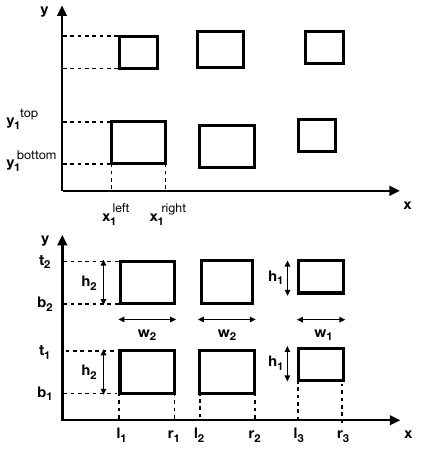
Figure 4. Names of float variables for rectangle coordinates (upper image) and for alignment classes height and width values. Number m denotes an upper bound for the expected number of different top or bottom window co- ordinates. Accordingly, number n is an upper bound for win- dow column positions. Obviously, it does not make sense to choose m, n > N . But to reduce the number of variables, up- per bounds smaller than N are welcome. The estimated number of building floors (height of the facade divided by three) ap- length (in meter) is an estimate of a lower bound for